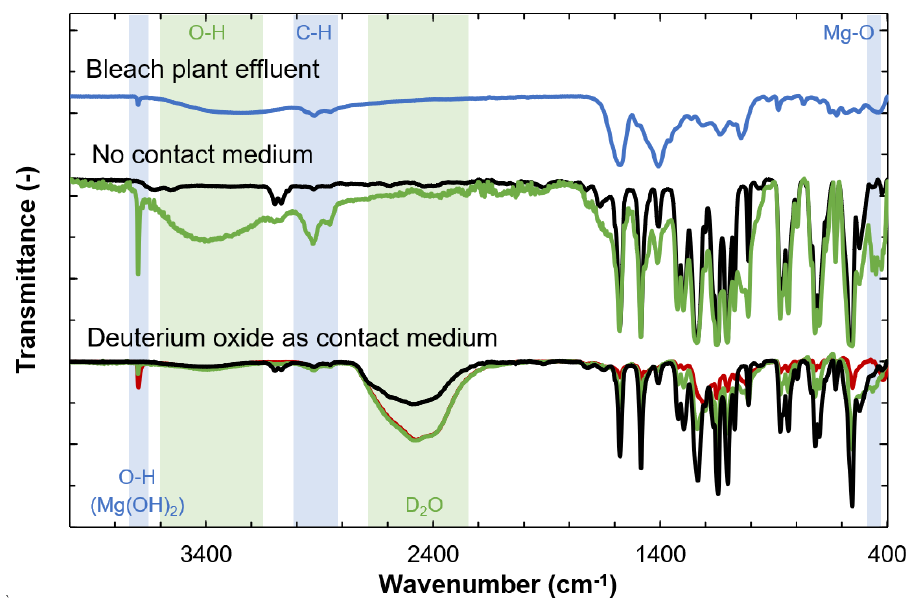
Figure 9. Attenuated total reflection-Fourier transform infrared spectroscopy (ATR-FTIR) spectra obtained from: lyophilized bleach plant effluent ( blue line ), a pristine membrane ( black line ), a membrane cleaned for 1 h ( red line ) and a membrane cleaned for 20 h ( green line ). The contact between the ATR crystal and the sample was increased by using deuterium oxide as contact medium. No spectra were obtained for the membrane cleaned for 1 h when not using any contact medium but was successful when using deuterium oxide as contact medium. The spectra are averages of three membrane